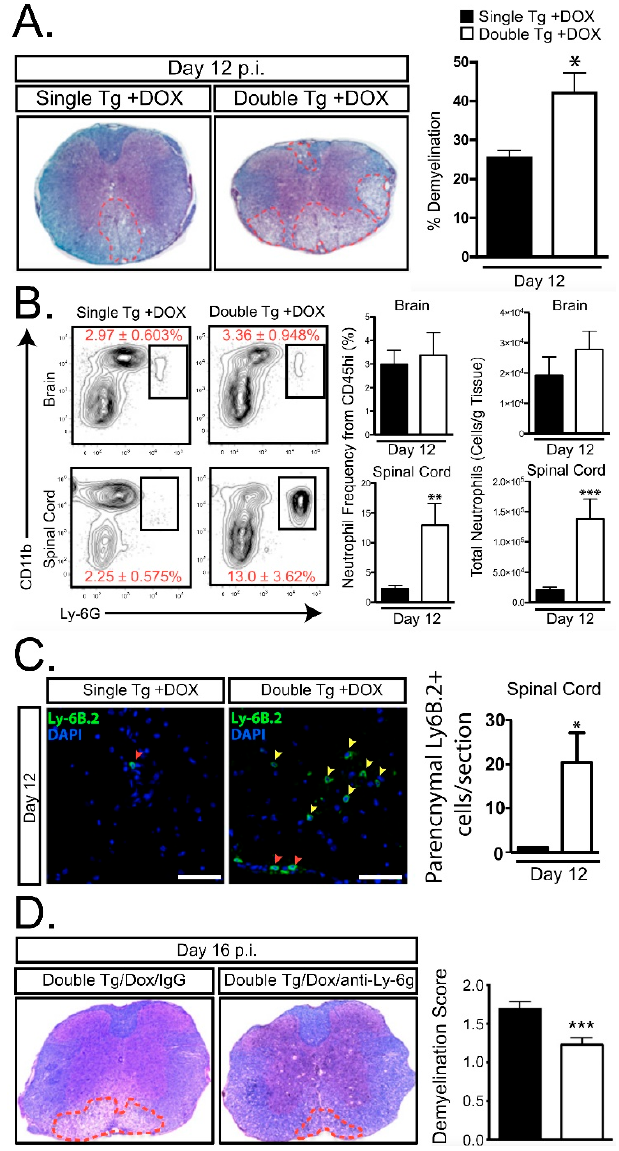
Figure 2 . Elevated CNS CXCL1 expression is associated with increased neutrophil accumulation and demyelination. ( A ) Representative luxol fast blue (LFB)-stained spinal cords reveals increased ( p < 0.05) demyelination in mouse hepatitis virus (JHMV)-infected Dox-treated double tg mice compared to single tg controls. (B) Flow cytometric analysis revealed a significant increase in the frequency and total number of neutrophils within the spinal cord of JHMV-infected Dox-treated double tg mice compared to single tg mice. ( C ) Representative immune-fluorescence staining further demonstrated a significant increase in the number of Ly6B.2-positive neutrophils (yellow arrowheads) within the spinal cord parenchyma of JHMV-infected double tg compared to single tg mice; red arrowheads indicate neutrophils located within the spinal cord meninges. Quantification of neutrophils within the spinal cords indicated an overall increase ( p < 0.05) in Dox-treated double tg mice compared to Dox-treated single tg mice. ( D ) Representative LFB-stained spinal cord sections from JHMV-infected double tg mice treated with either control IgG2a or anti-Ly6G antibody between days 3 to 15 p.i. Quantification of the severity of demyelination revealed reduced white matter damage in mice treated with anti-Ly6G antibody compared to mice treated with isogenic IgG2a control antibody. * p < 0.05, ** p < 0.01, *** p < 0.001. Data derived from Marro et al., (2016) [101].